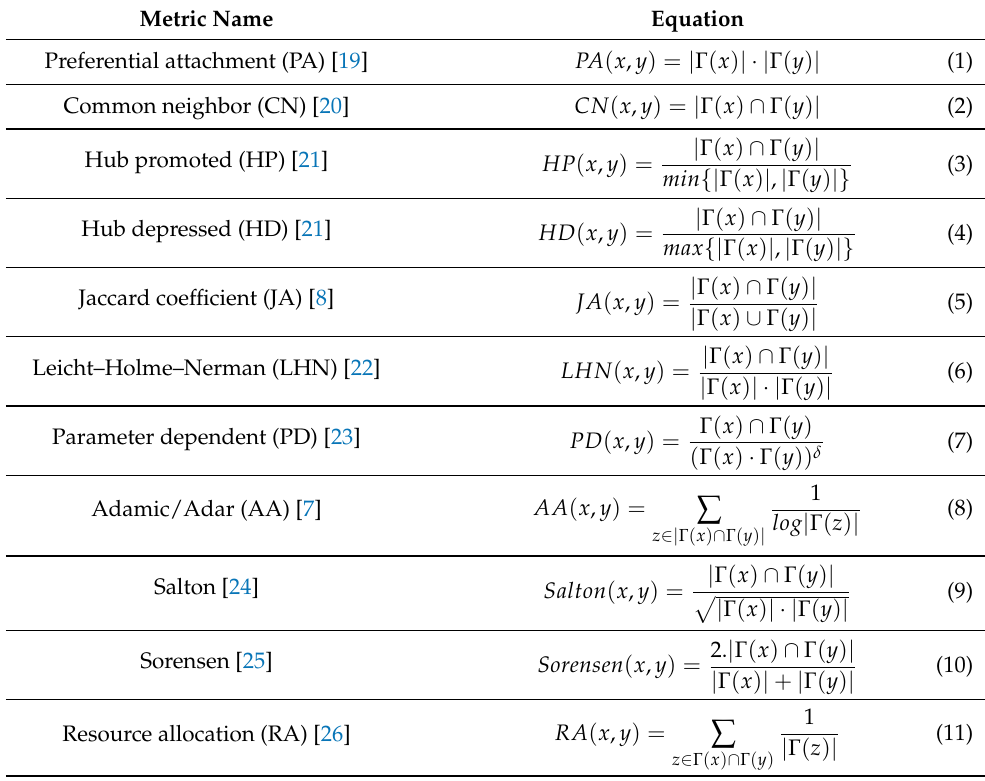
Table 1. Neighborhood-based similarity